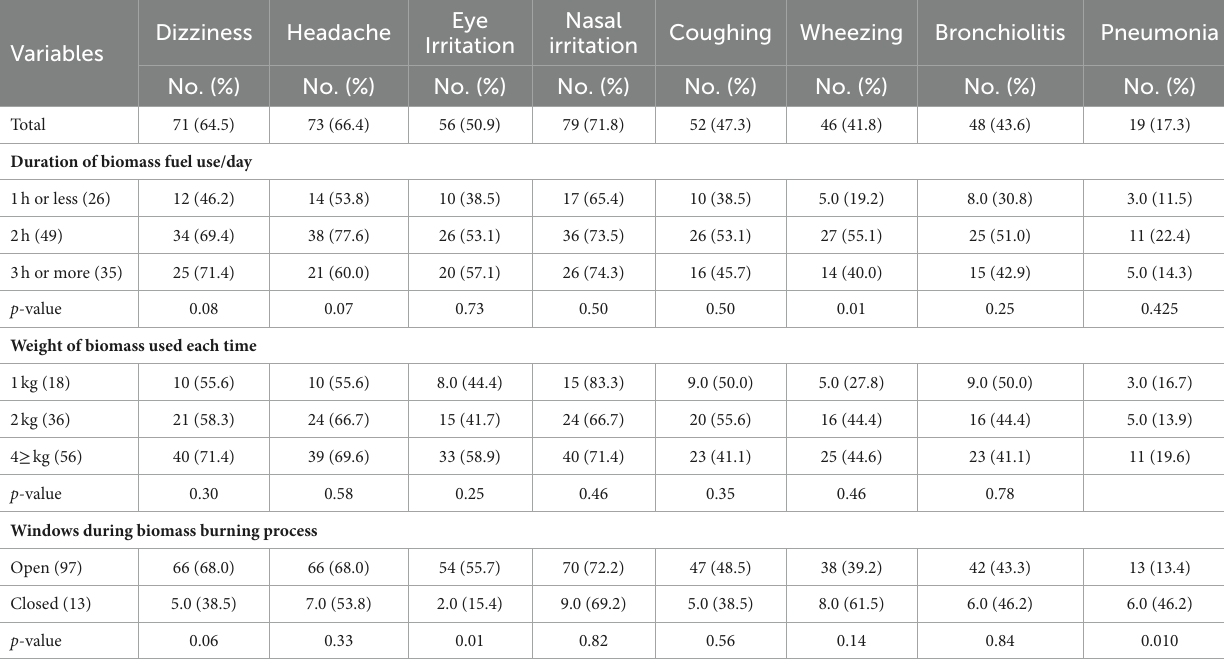
TABLE 8 Association between duration, estimated weight used each time, and open windows during the burning process with common symptoms/ morbidities among respondents.